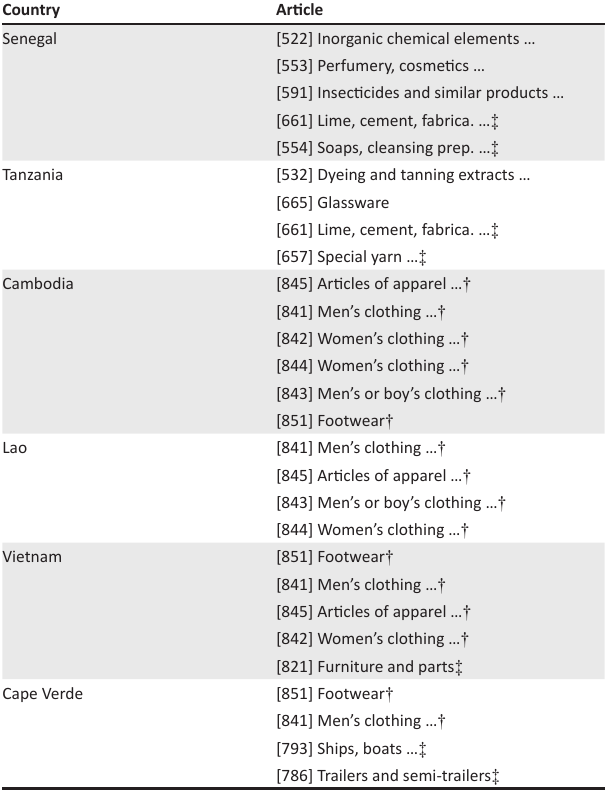
TABLE 4: Long-term RCA of Senegal and comparator economies in manufacturing industries (RCA among top 10 in at least four out of following five years: 1995, 2000, 2005, 2010 and 2015).